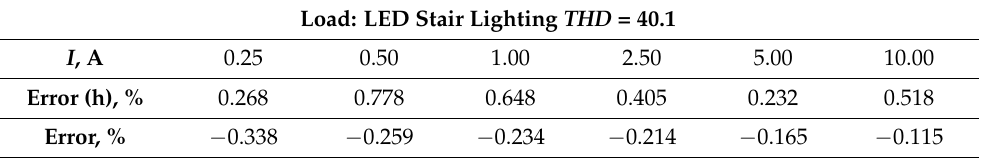
Table 4. Dependence of the electronic energy meter errors on the current value for THD = 40.1. Load: LED Stair Lighting THD = 40.1